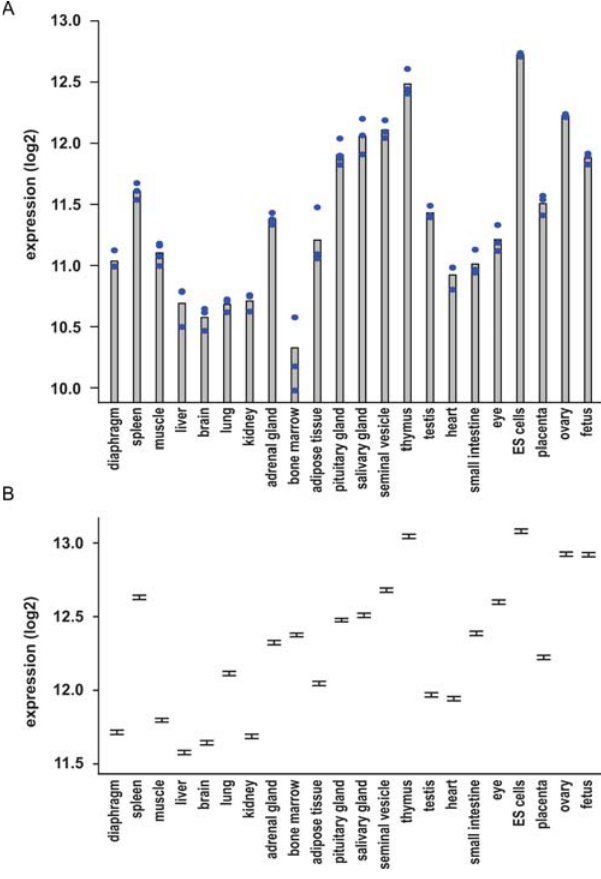
Figure 2. Tissue-specific co-expression of ribosomal protein genes. (A) Expression of Rps13 in 22 different tissues. Individual measurements are displayed as blue dots and average corresponds to the top of the grey bars. Expression values are displayed in log2 scale. (B) Marginal means (estimated under the two-way ANOVA) of all ribosomal protein genes in each of the tissues, together with the 95 percent confidence interval.